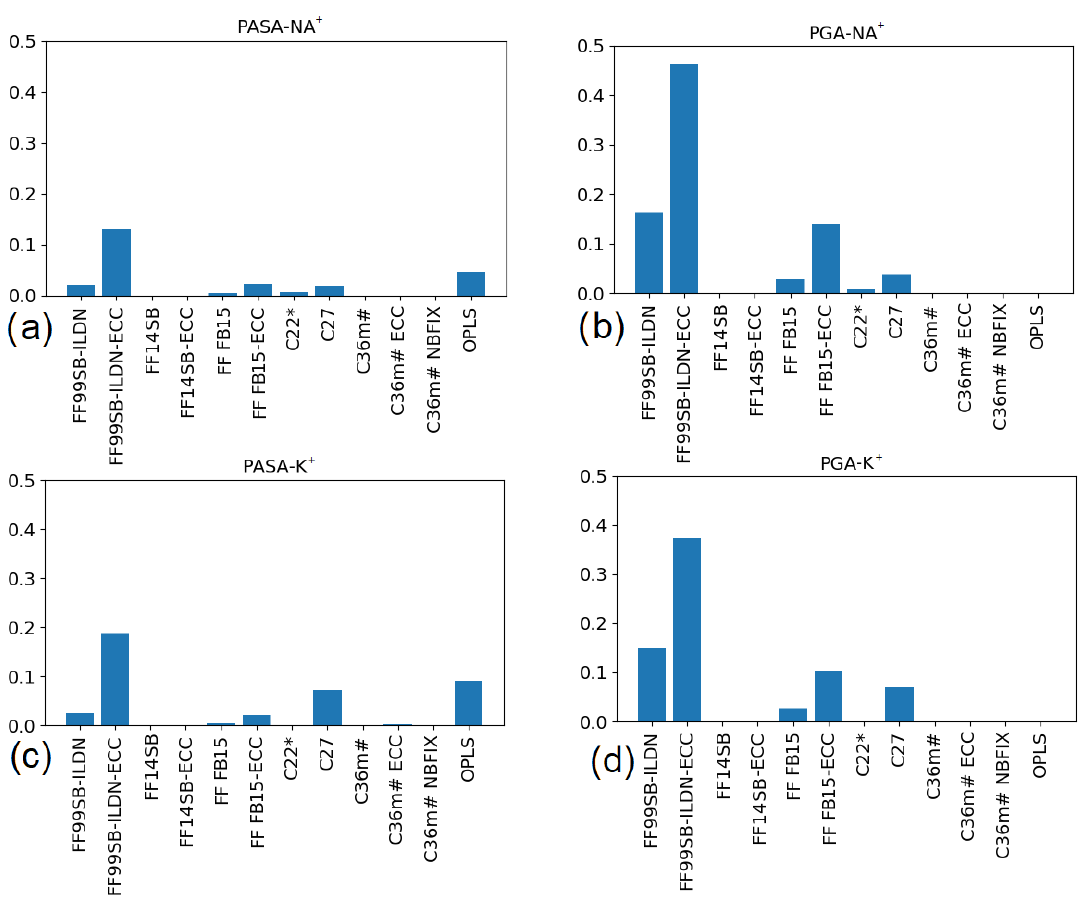
Figure 8. Fractions of PASA ( a , c ) and PGA ( b , d ) monomers included in the α R -helical sequences (more than three monomers).